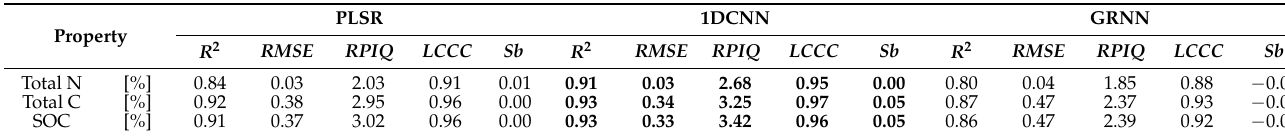
Table 3. Summary of model validation statistics for C and N concentration in soils. The best prediction result for particular variables is marked in bold.